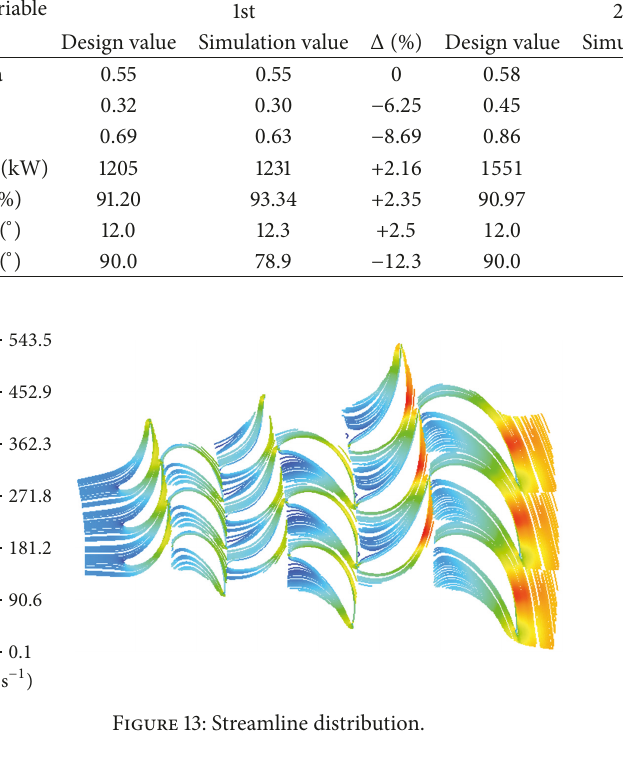
Table 8: The contrast of design value and CFD value of each stage performance of the centrifugal turbine. Variable